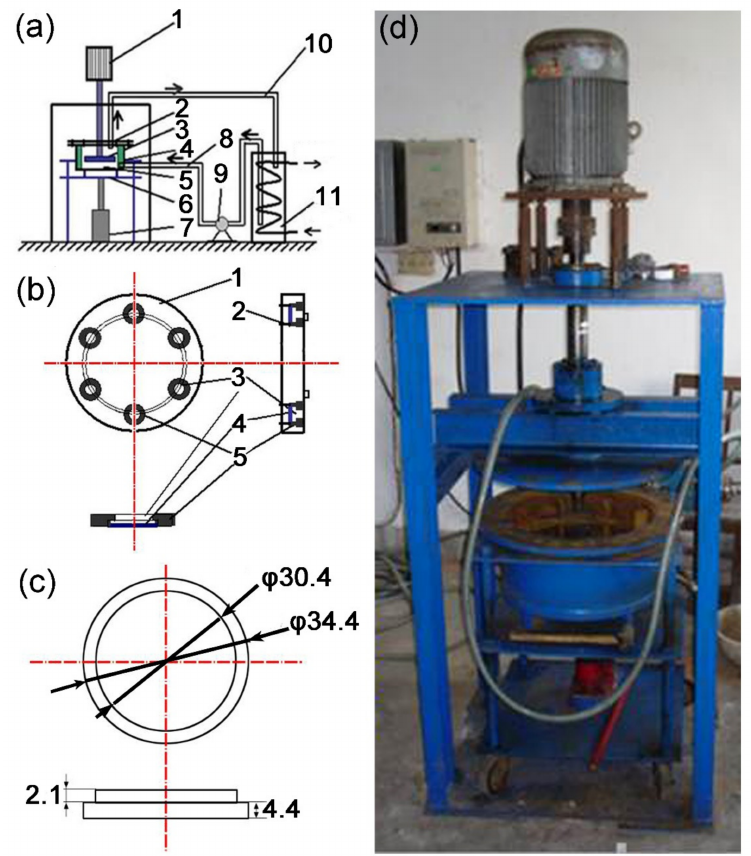
Figure 2. ( a ) Schematic diagram of homemade rotating disc electrode (RDE): (1) motor, (2) bolt, (3) rotating disk, (4) baffle, (5) water trough, (6) bracket of water trough, (7) jack, (8) water inlet, (9) circular cooling water, (10) water outlet and (11) cooling device. ( b ) Schematic diagram of rotating disk: (1) disk, (2) bolt, (3) specimen, (4) plastic mat and (5) nylon clamp. Schematic diagram of ( c ) specimen. ( d ) Digital picture of homemade